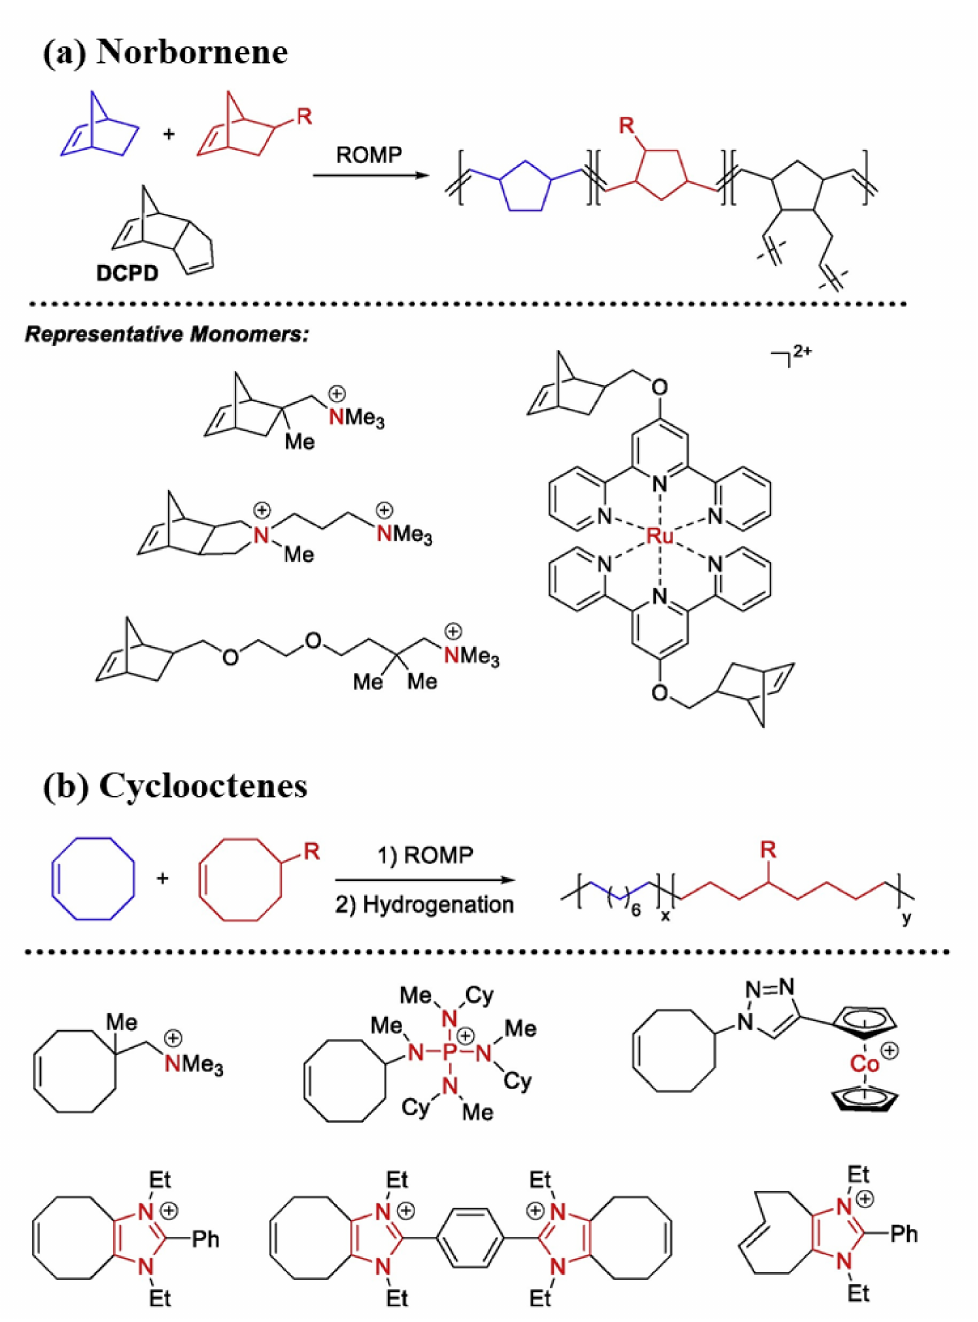
Figure 12. Direct polymerization via the ROMP of ( a ) norbornene; ( b ) cyclooctenes derivatives (Reprinted with permission from ref. [176], Copyright 2018 American Chemical